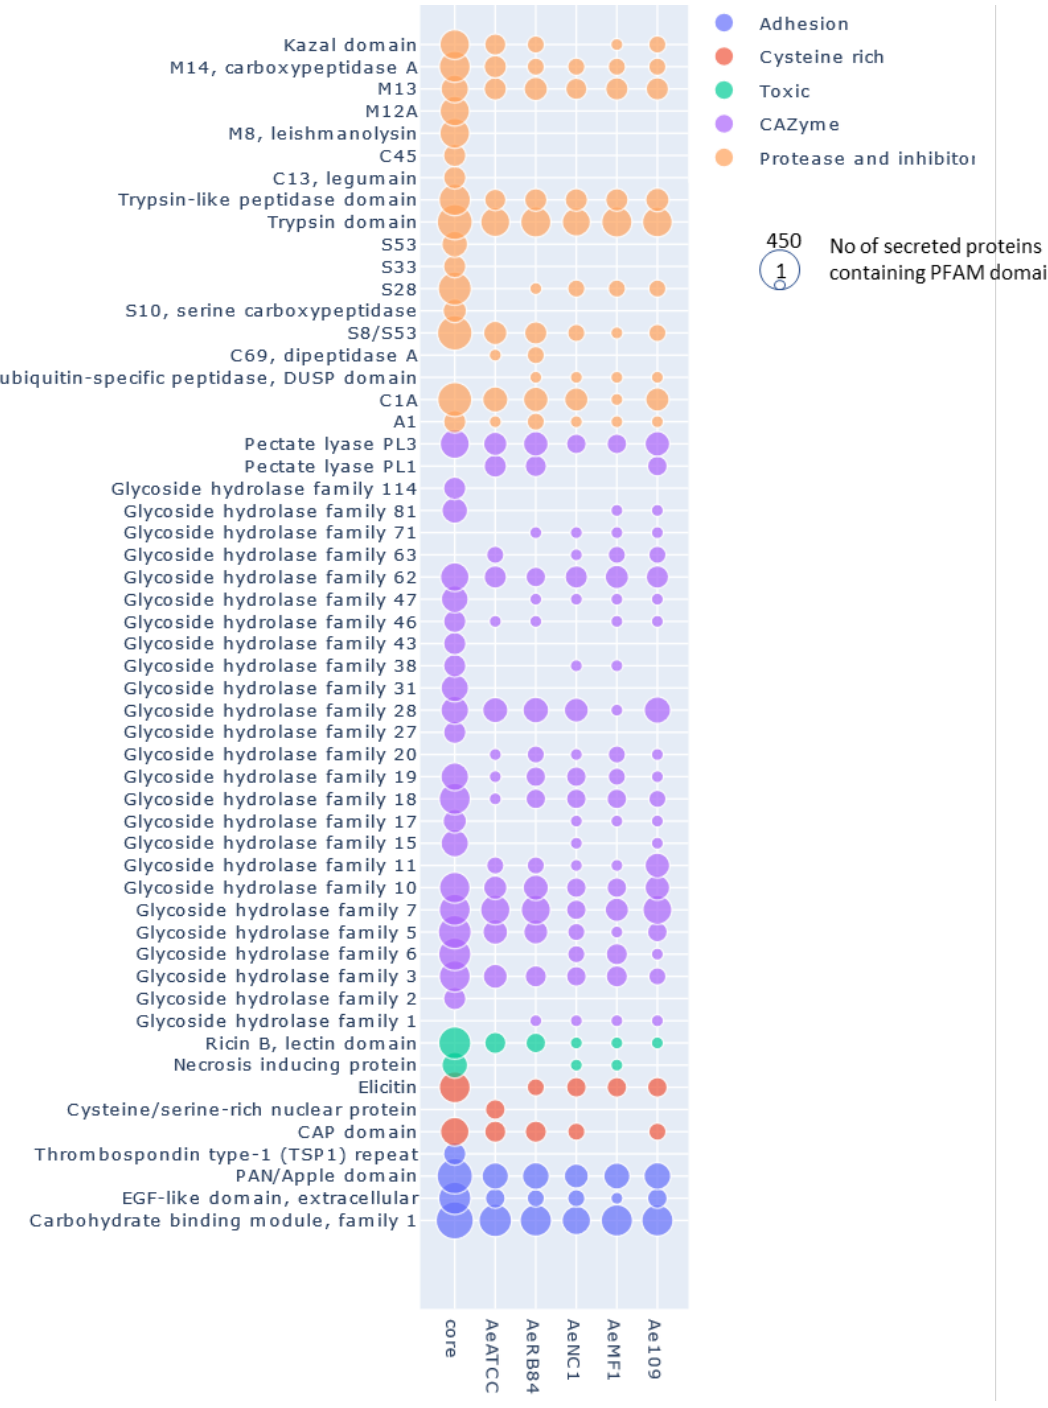
Figure 9. Distribution of secreted proteins containing a PFAM domain in the core and accessory secretome of A. euteiches . The first ‘core’ column represents the number of secreted proteins containing PFAM domains found in core orthogroups; the other columns represent the numbers of accessory and singleton orthogroups. The size of the circle corresponds to the log10 + 1 number of secreted proteins with a PFAM domain.